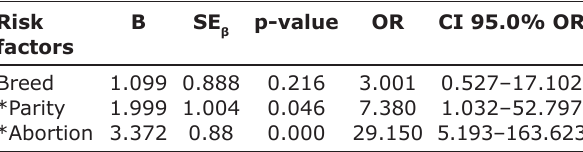
Table-3: Result analysis, through the multiple logistic regression, of risk factors associated with the seroprevalence of sampled